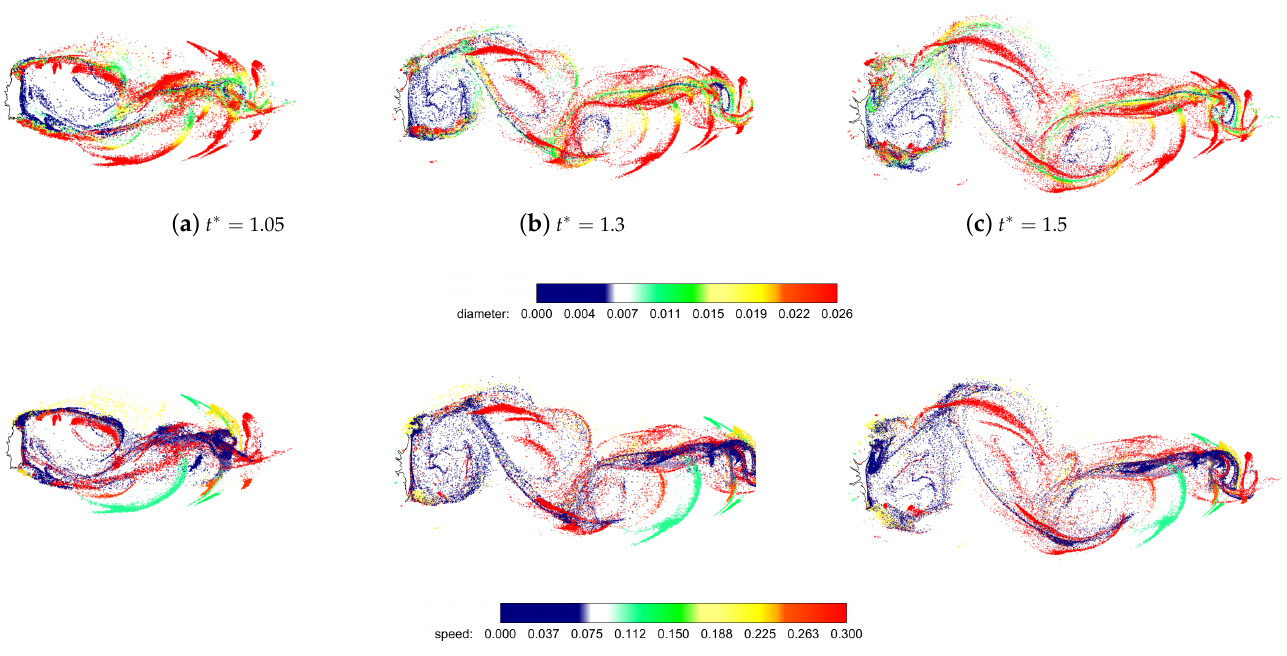
Figure 9. Plane views in the midplane y = 0 of instantaneous positions of DPM particles at three typical time instants, colored by either nondimensional diameter ( top ) or speed ( bottom